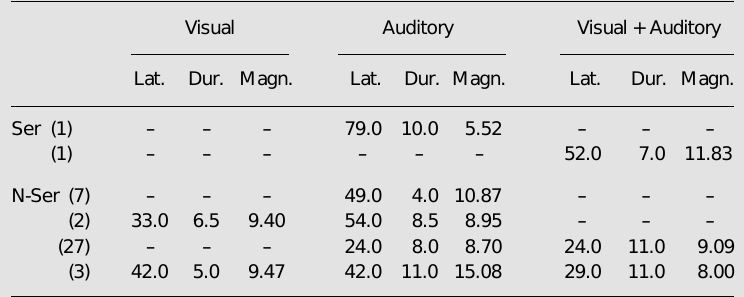
Eight serotonergic neurons (Ser) and 57 non-serotonergic neurons (N-Ser) were tested. Lat., latency; Dur., duration; Magn., magnitude. The number of neurons is given in